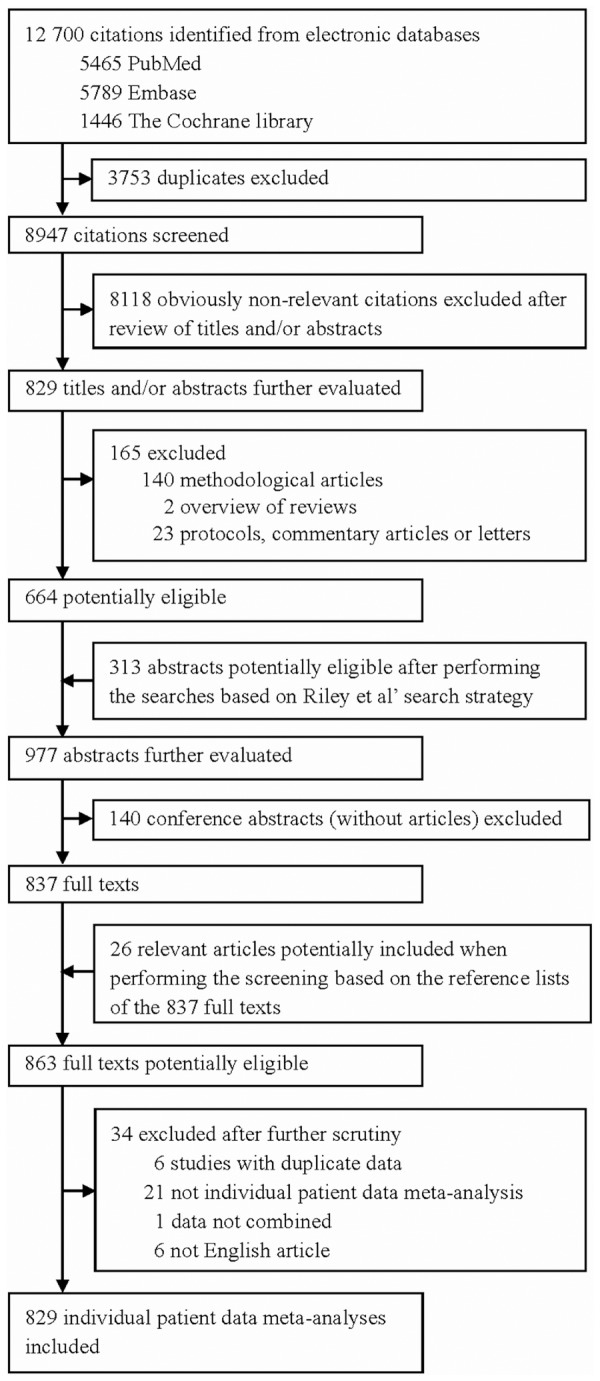
Flowchart of the literature search.